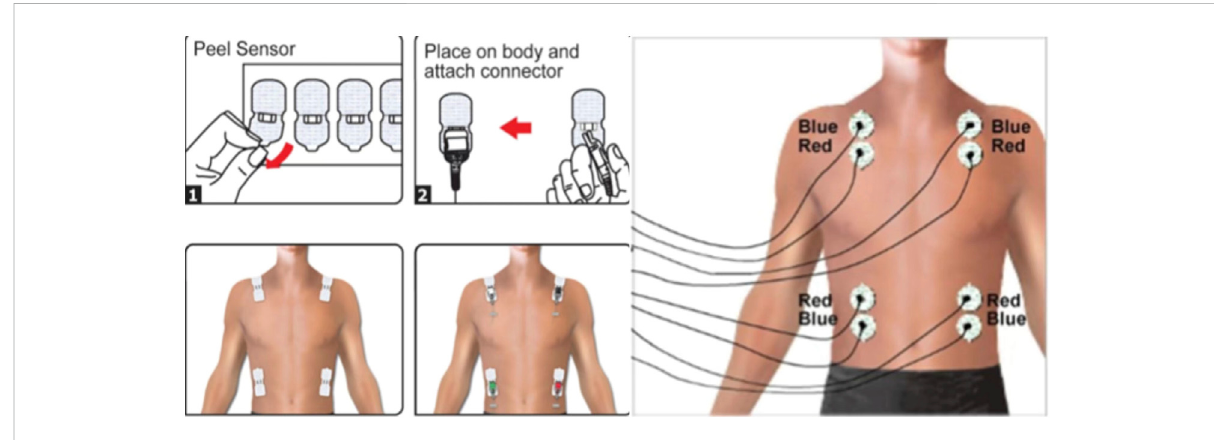
FIGURE 2 NICOM Reliant system schematic diagram of electrode position.